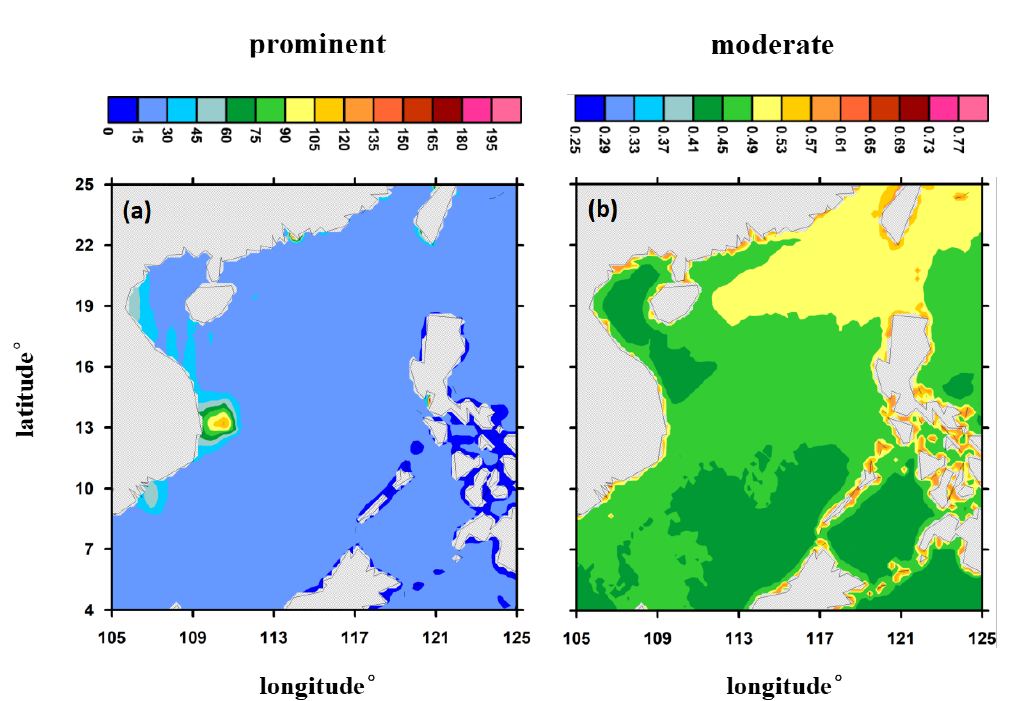
Figure 9. The yearly merged RFI map. ( a ) The prominent RFI map and ( b ) the moderate RFI map are yearly merged RFI maps of 2018, presenting contamination condition for the whole year. All images have been truncated to SCS region. The light gray in the images represents the land area.